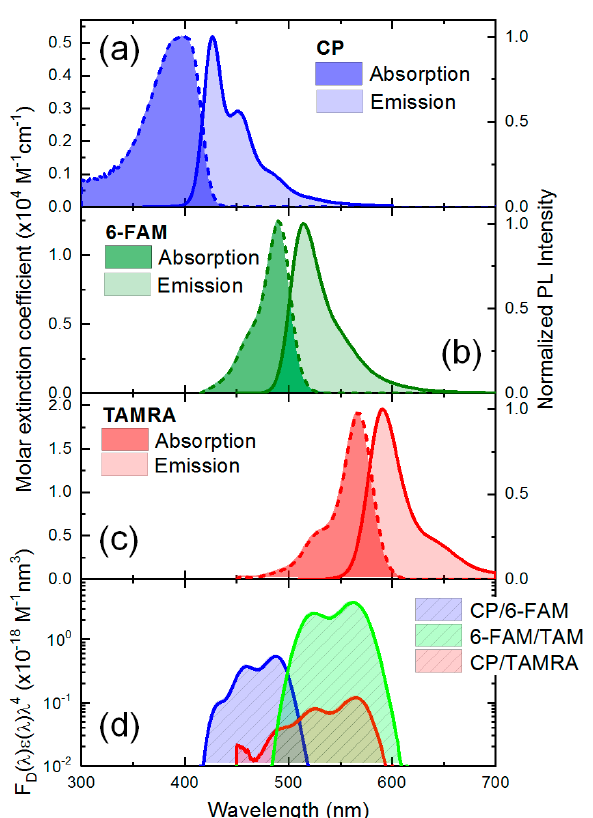
Figure 2. The optical properties of the three fluorophores (i.e., CPs, 6-FAM, and TAMRA) and the spectral overlap among them. The absorption and the emission spectra of ( a ) CPs; ( b ) 6-FAM; and ( c ) TAMRA were characterized in terms of the molar extinction coefficient and normalized by the maximum fluorescence intensity, respectively; ( d ) The spectral overlap between the three fluorophores was calculated by integrating the product of the absorption spectra and the emission